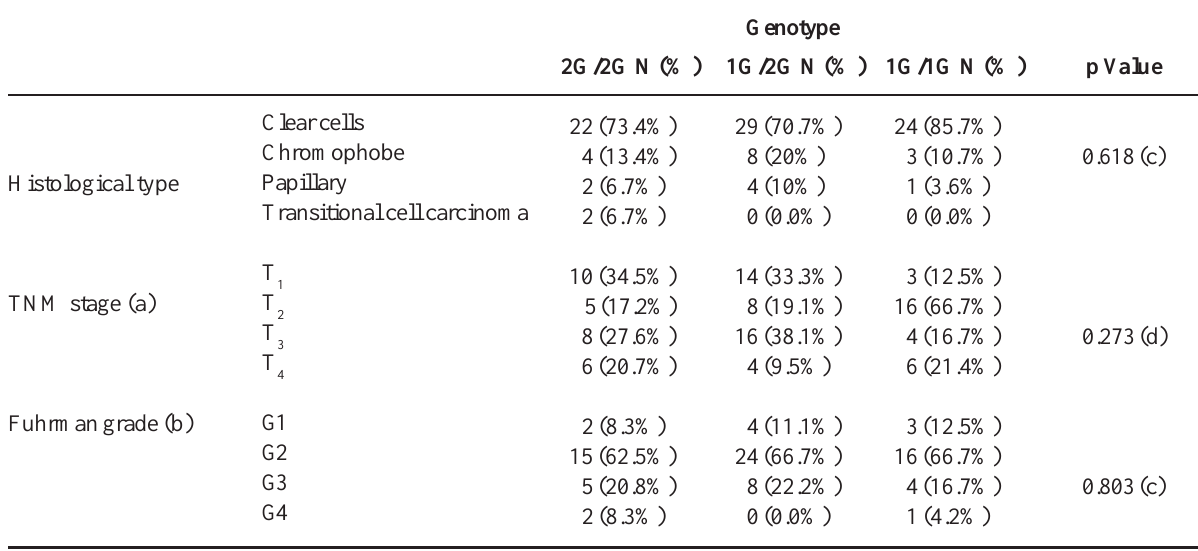
Table 4 – Correlation between pathological data and genotype frequency of MMP-1 polymorphism in RCC patients.